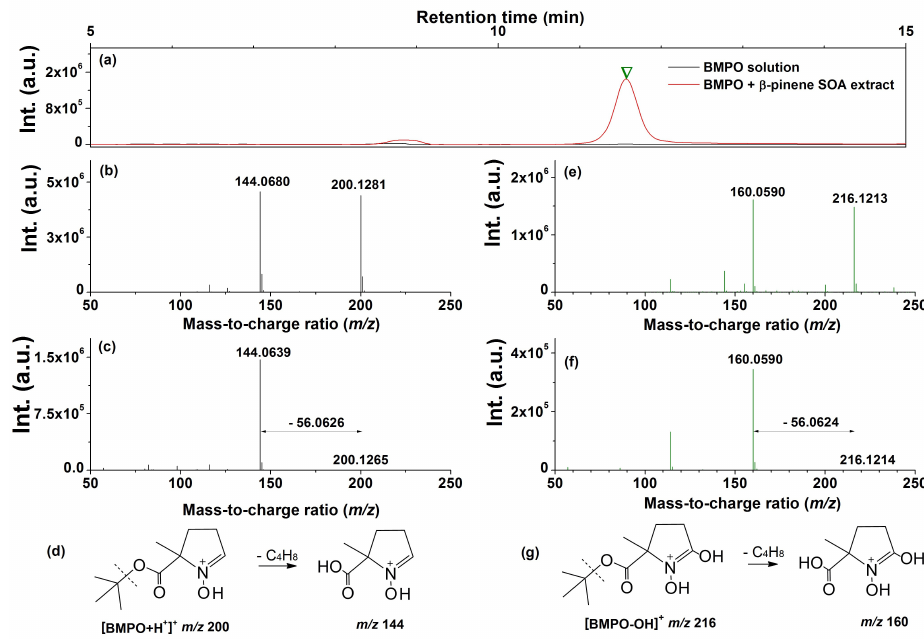
Figure 3. LC-MS/MS analysis. (a) LC-MS chromatogram of aqueous BMPO solution (black line) and BMPO mixed with β -pinene SOA water extracts (red line). The downward triangle indicates the retention time of m/z 216 (BMPO-OH). (b) MS spectrum of [BMPO + H + ] + with nominal m/z 200. (c) MS 2 spectrum of m/z 200, with the characteristic fragment ion m/z 144.0639 ([BMPO + H + ] + − m/z 56.0626). (d) Proposed fragmentation pathway for m/z 200. The most abundant fragment ion present in (c) corresponds to the loss of C 4 H 8 from [BMPO + H + ] + . (e) MS spectrum of [BMPO-OH] + with m/z 216. (f) The MS 2 spectrum of m/z 216, with the characteristic fragment ion m/z 160.0590 ([BMPO-OH] + − m/z 56.0624). (g) Proposed fragmentation pathway for m/z 216. The observed loss of C 4 H 8 is characteris- tic of the fragmentation of the t -butoxycarbonyl function of BMPO.